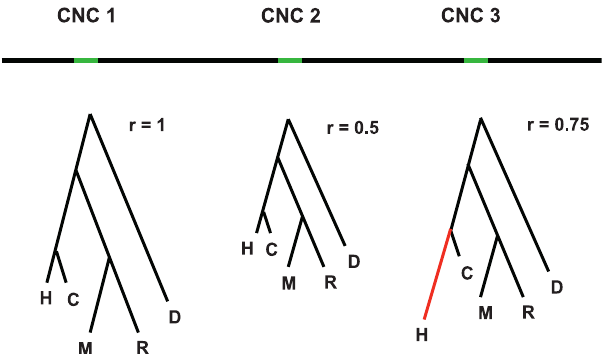
Figure 1. Schematic Illustration of Our Method Applied to Three CNCs The tree beneath each CNC shows hypothetical branch lengths for the phylogeny connecting human, chimpanzee, mouse, rat, and dog (H, C, M, R, and D, respectively). Each CNC is associated with a single rate parameter r that accounts for variation in the local mutation rate and level of conservation; however, under the null model, the relative branch lengths are all the same. CNC 3 has an unusually long human branch suggesting positive adaptation on the human lineage.